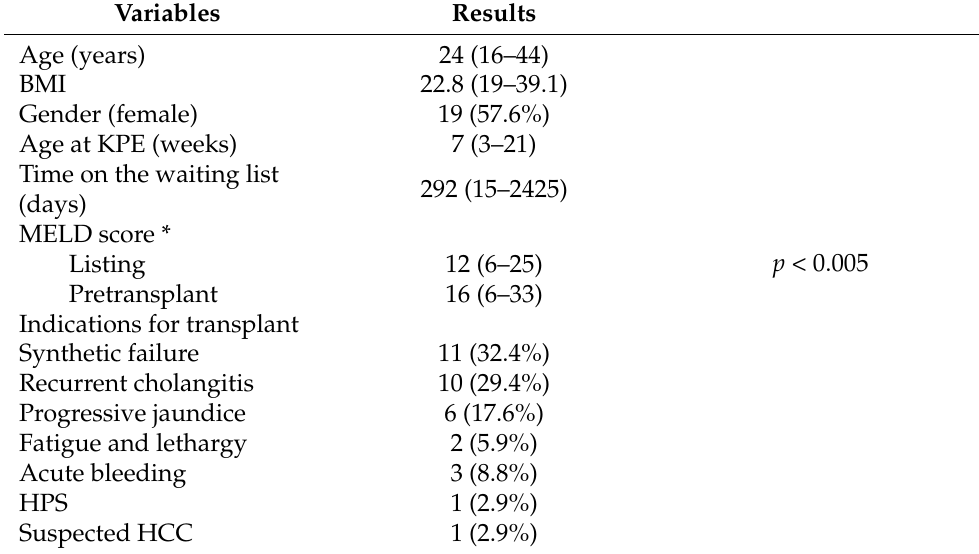
Table 1. Recipient